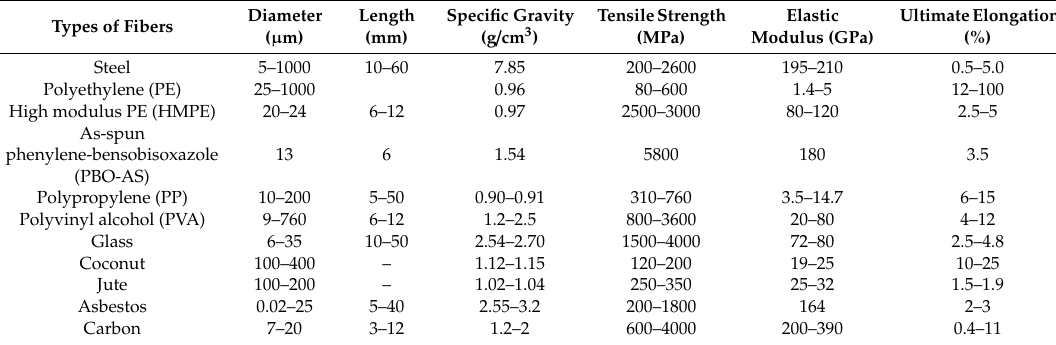
Table 1. Physical properties of commonly used fiber types in